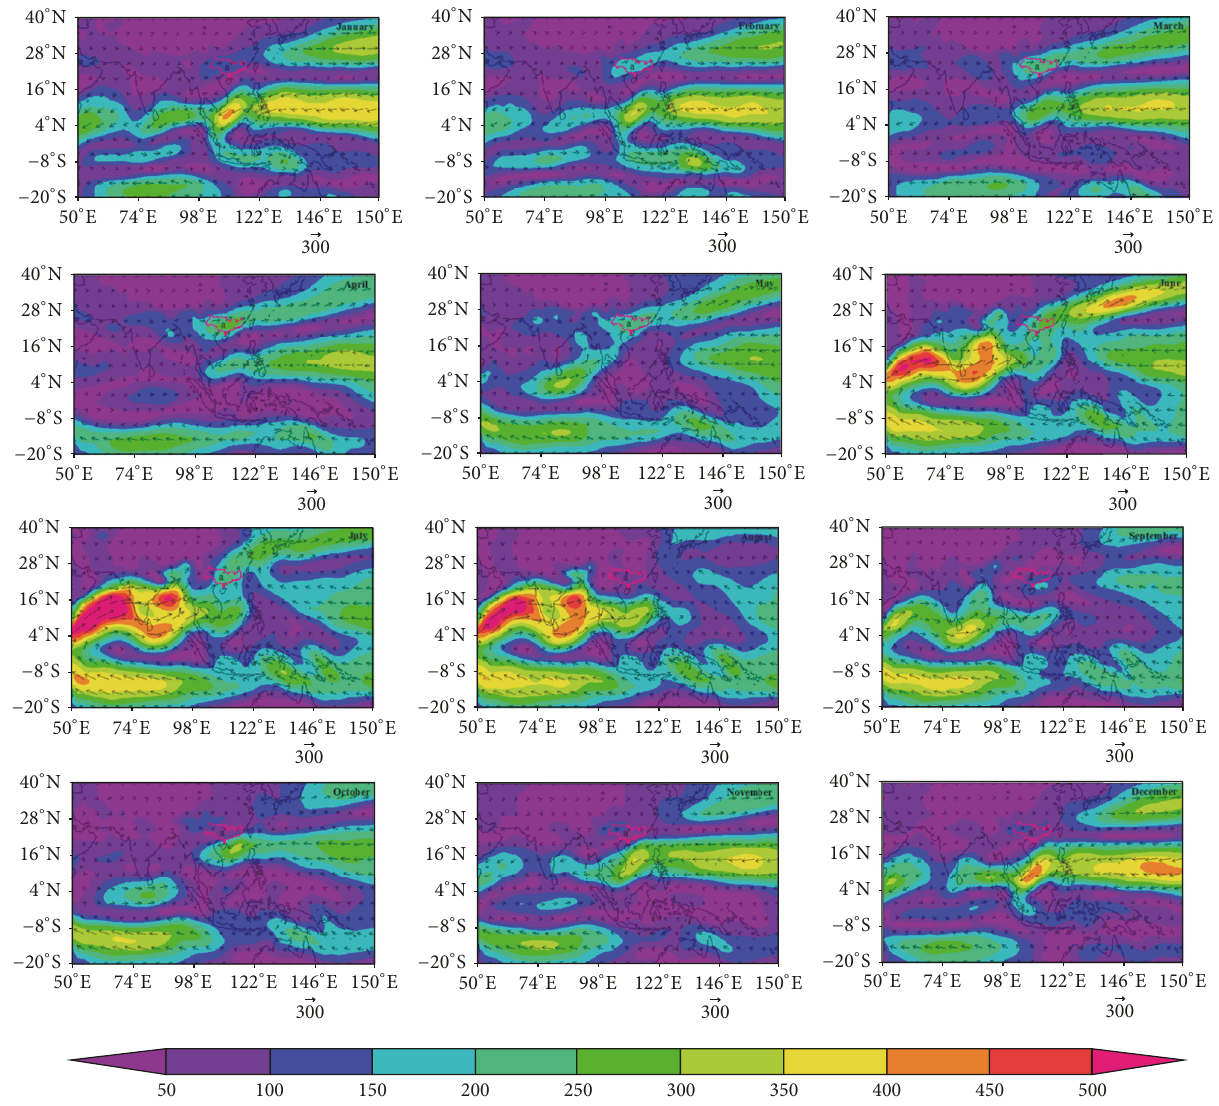
Figure 5: Vertically integrated mean moisture transport (kgm −1 s −1 ) for each month from 1980 to 2011 over Pearl River basin (a) and adjacent regions. Note: the unit of the color scale is kgm −1 s −1